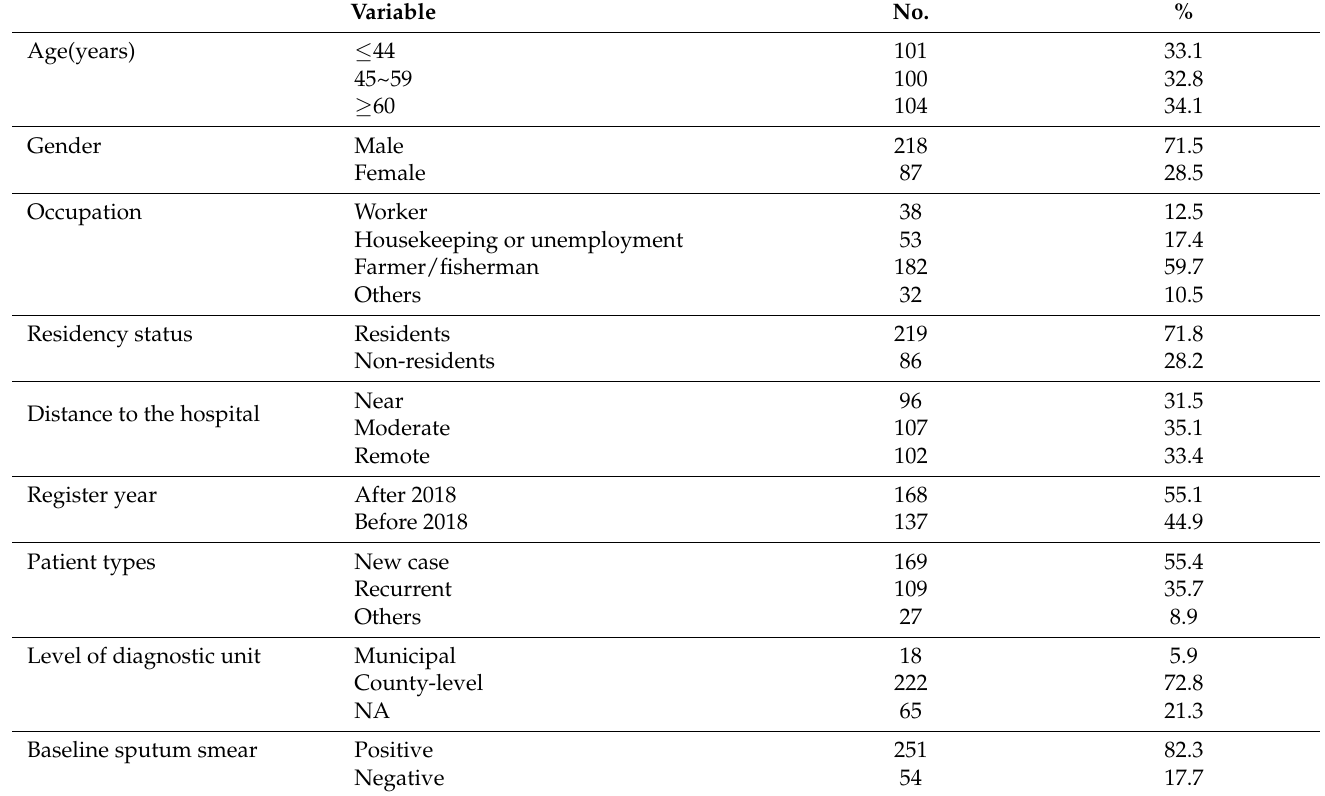
Table 1. Clinical and demographic characteristics of MDR/RR-TB patients. (N =